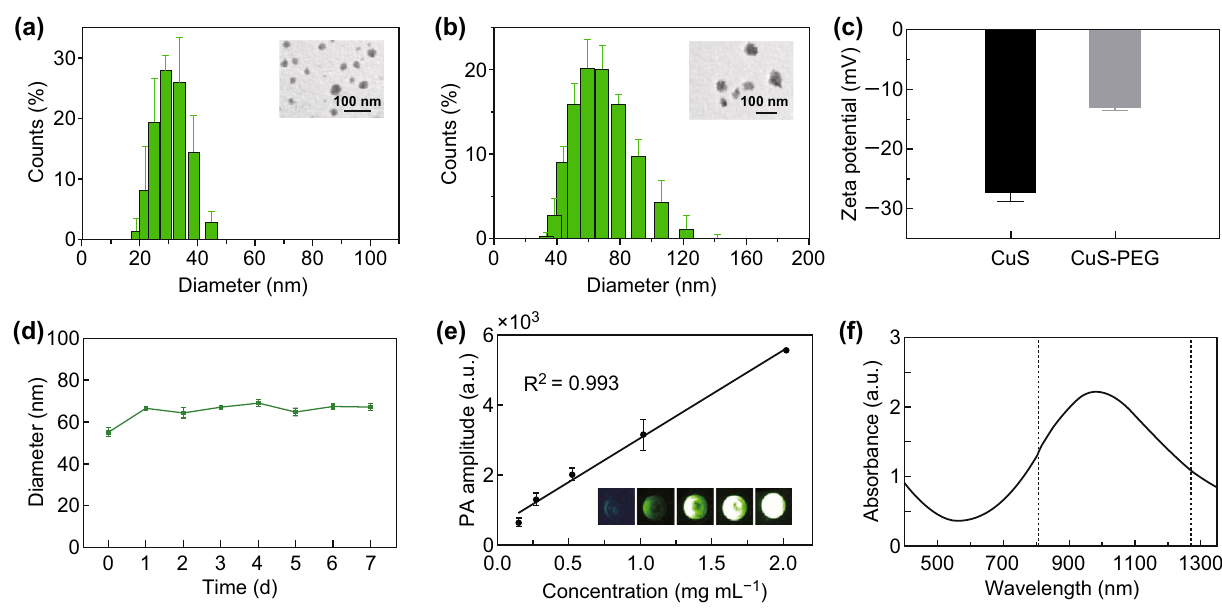
Fig. 1 Characterization of CuS NPs and CuS-PEG NPs. a Morphology and size of CuS NPs. b Morphology and size of CuS-PEG NPs. c Apparent zeta potential of CuS NPs and CuS-PEG NPs. d Diameters of CuS-PEG NPs stored in FBS. e Linear fitting plots of PA amplitudes versus the concentration of CuS-PEG NPs under NIR laser irradiation. The inset is the PA image of CuS-PEG solution with different concentra- tions. f Absorption spectrum of CuS-PEG NPs. The error bars represent standard deviations ( n = 3 per